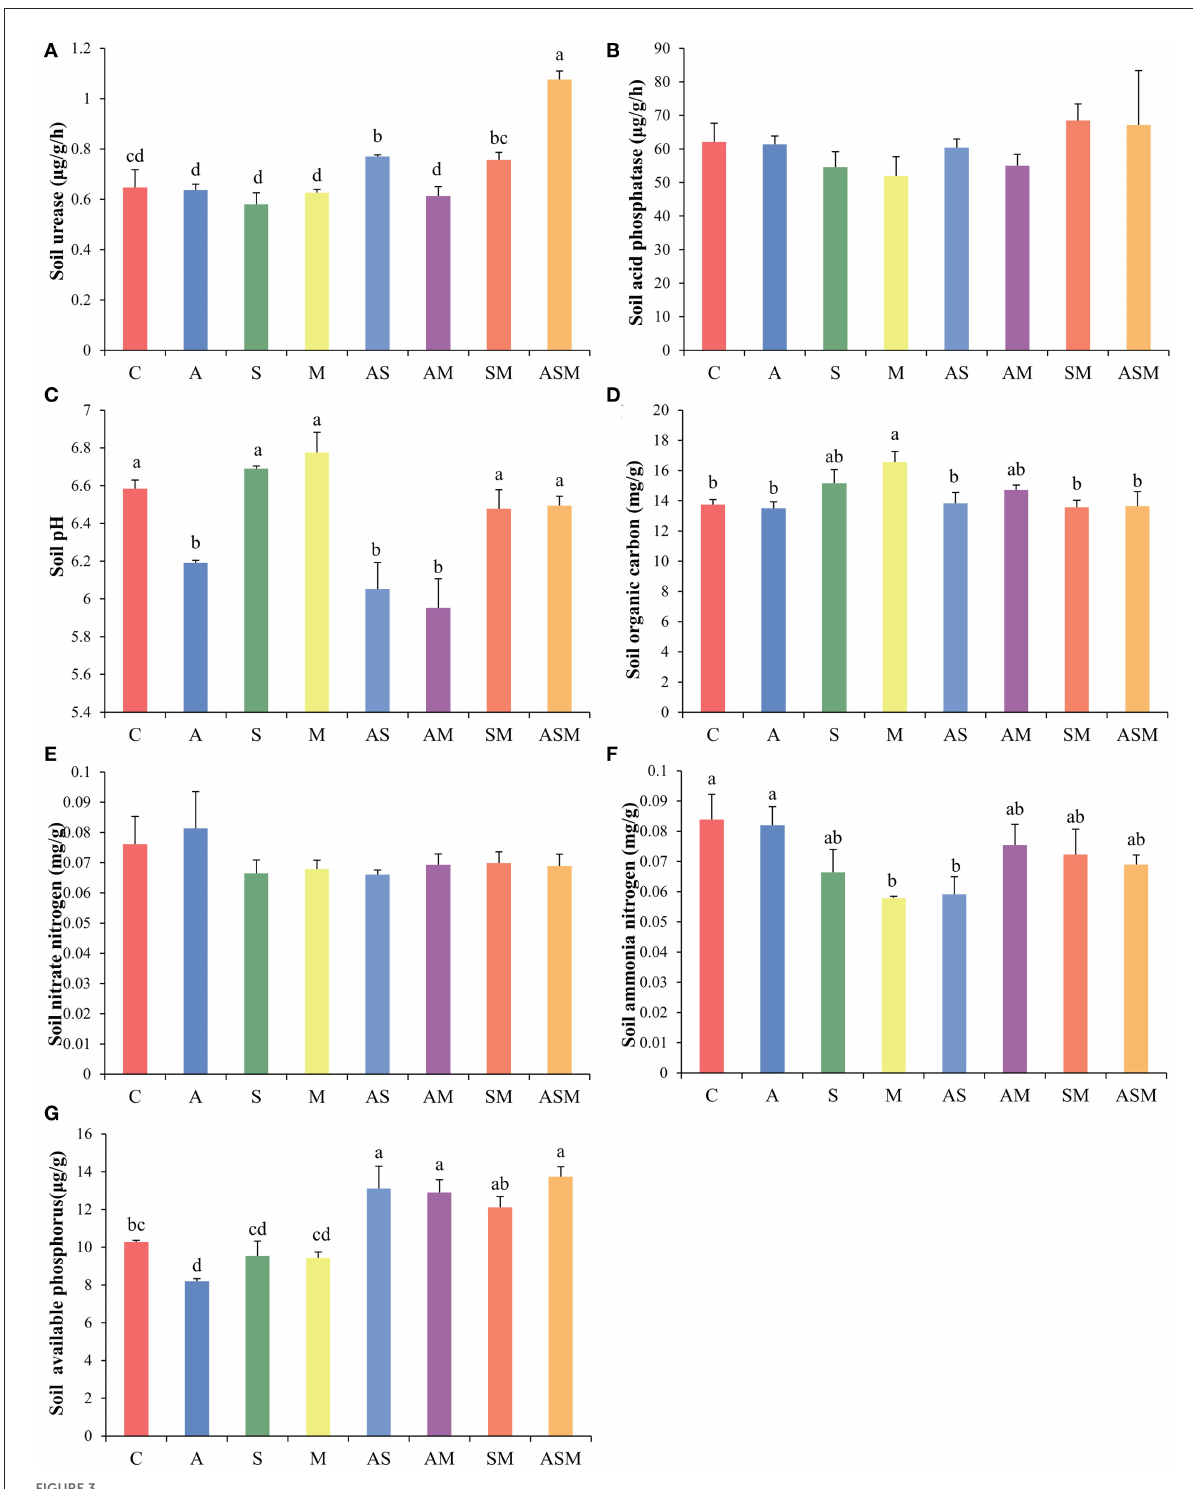
FIGURE3 Effects of combined inoculation effects of root endophytic fungi on soil enzymes and physicochemical properties of A. adsurgens seedlings. (A) Soil urease, (B) soil acid phosphatase, (C) soil pH, (D) soil organic carbon, (E) soil nitrate, (F) soil ammonia, and (G) soil available phosphorus. Different lowercase letters indicate significant differences (p < 0.05). C, non-inoculated control; A, inoculation with Alternaria chlamydospora ; S, inoculation with Sarocladium kiliense ; M, inoculation with Monosporascus sp .; AS, co-inoculation of Alternaria chlamydospora and